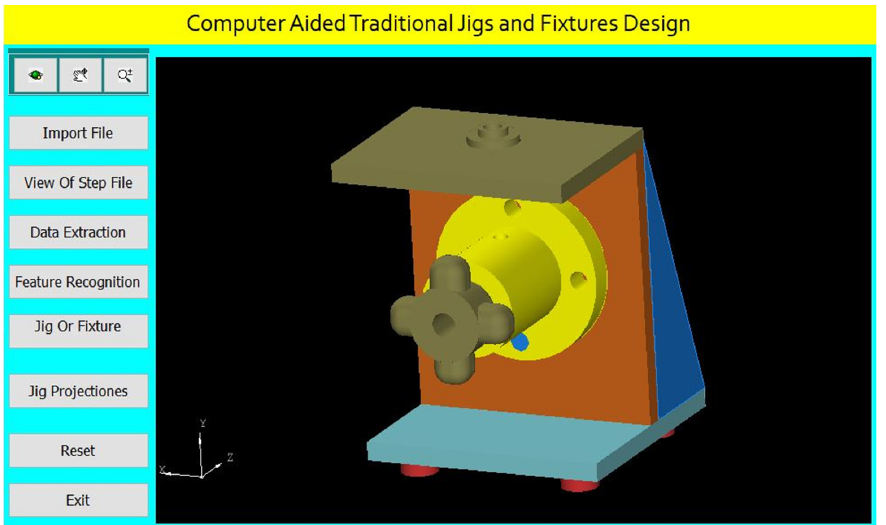
Figure 22. Computer-aided design of a jig for the cylindrical part.